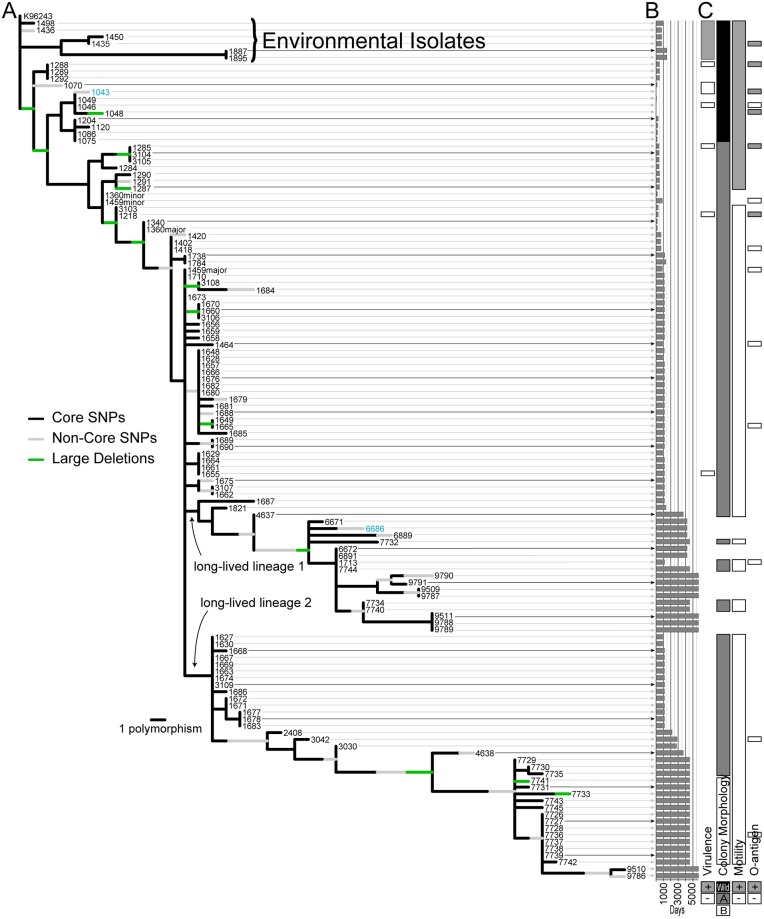
Evolutionary changes.(A) Phylogenetic tree showing evolutionary locations of polymorphism, (B) day of collection for each isolate, and (C) phenotypic characteristics (virulence, motility, and three colony morphotypes—W = wild type, A = small colony variants, B = fastidious). Core genome SNPs are represented as black branch segments, while non-core genome SNPs are gray. The large deletions shown in Fig 2 are green branch segments. We previously compared the genomes in blue [25]. Where mixtures are observed, the major and minor components are labeled. Methodological details for phylogenetic reconstruction are provided in the materials and methods section.